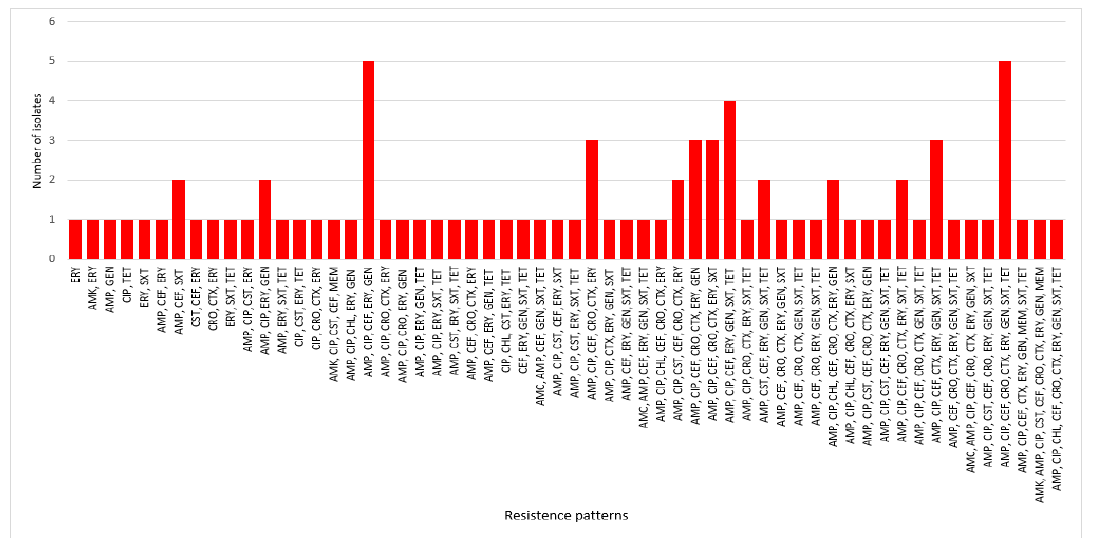
Figure 5. Antimicrobial resistance patterns of 83 isolates from disease-associated faecal samples (IBD/IC).